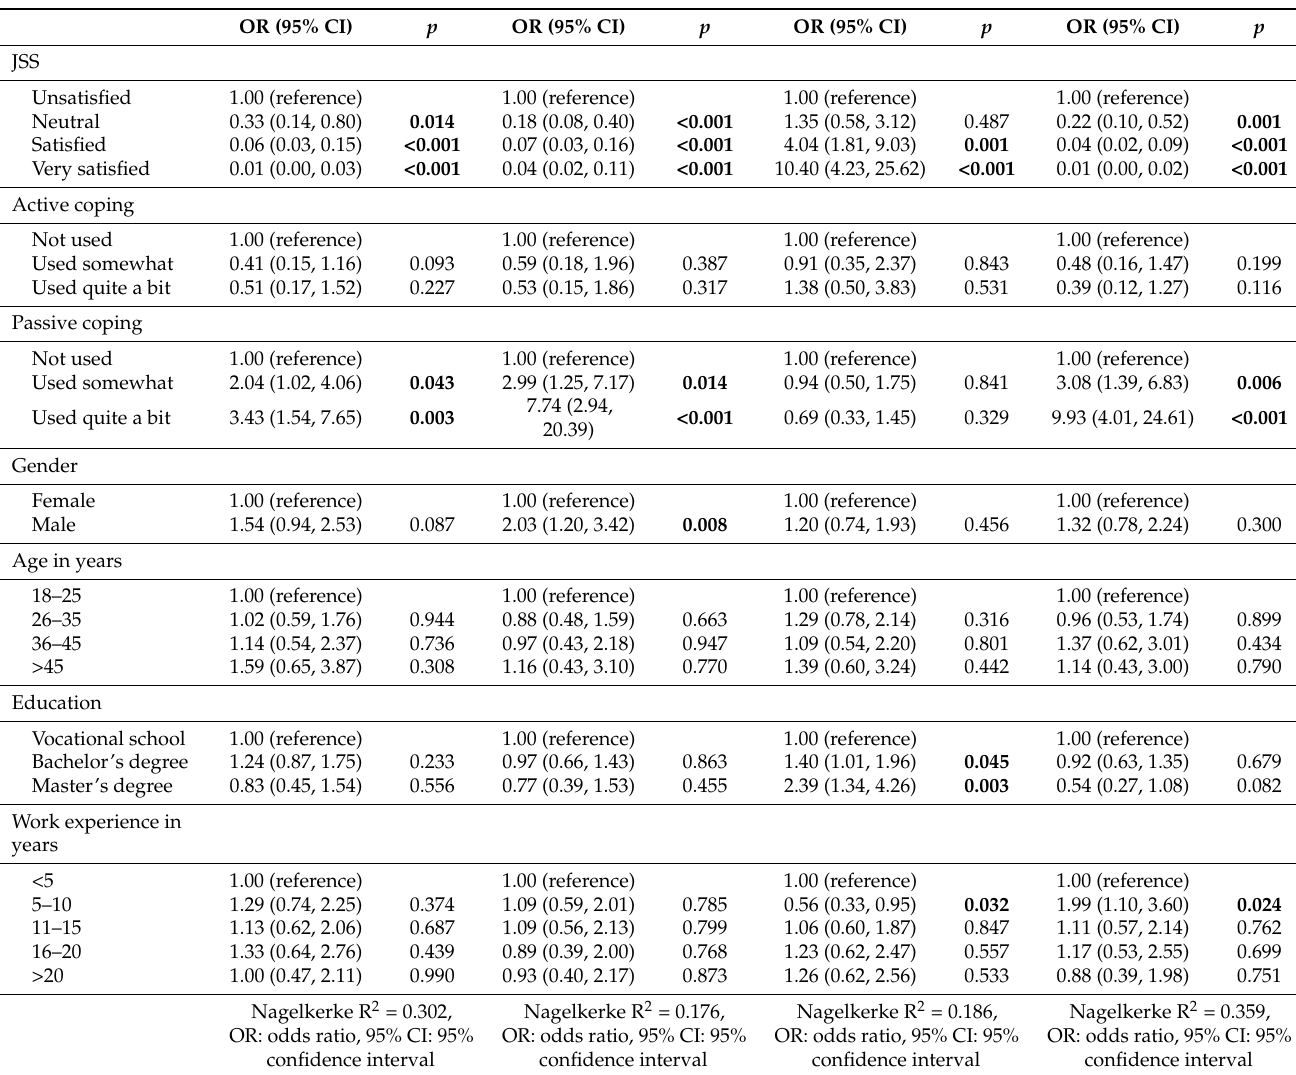
Table 3. Logistic regression model of variables associated with EE, DP, PA and MBI tot